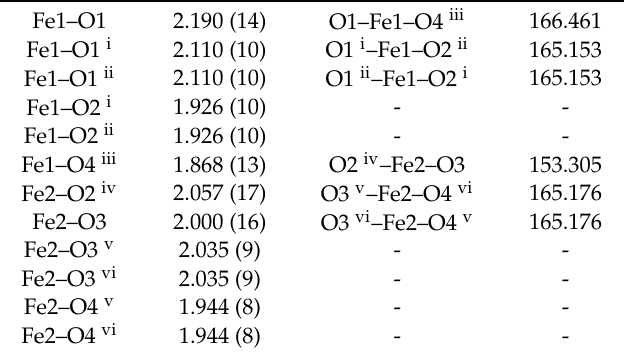
Figure 2. The refined octahedron units of Fe sites and Cl position in the newly proposed Ge ‐ akaganéite after the Rietveld refinement. The selected bond lengths are presented in Table 2. [Symmetry code(s): (i) – x + 3/2, y − 1/2, − z + 1/2; (ii) – x + 3/2, y + 1/2, − z + 1/2; (iii) x + 1, y , z ; (iv) – x + 1,